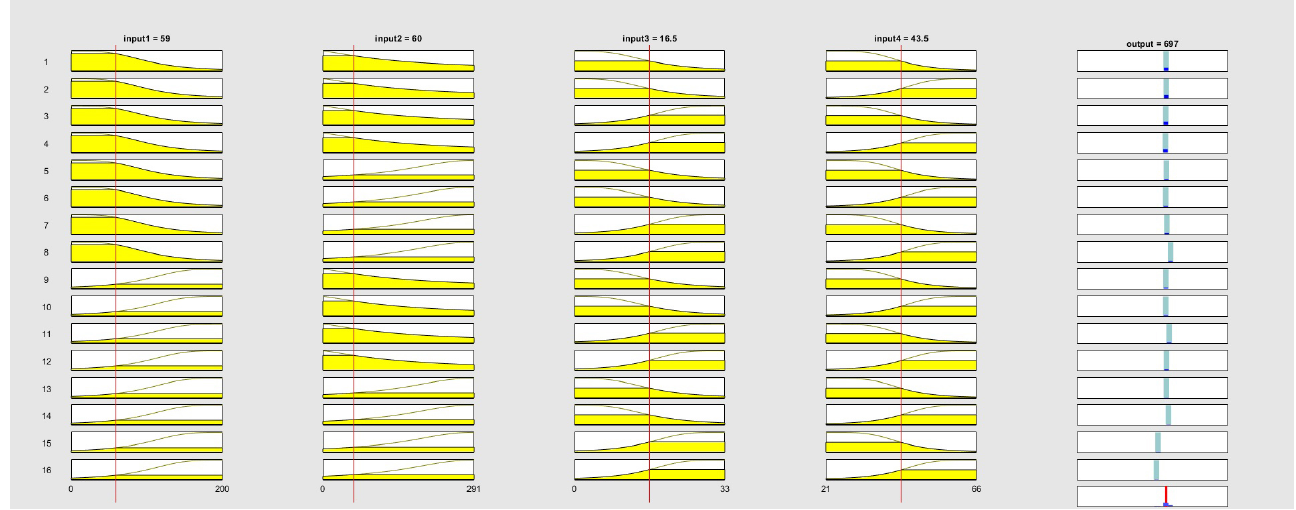
Figure 12. Rule viewer of the the fuzzy inference system.